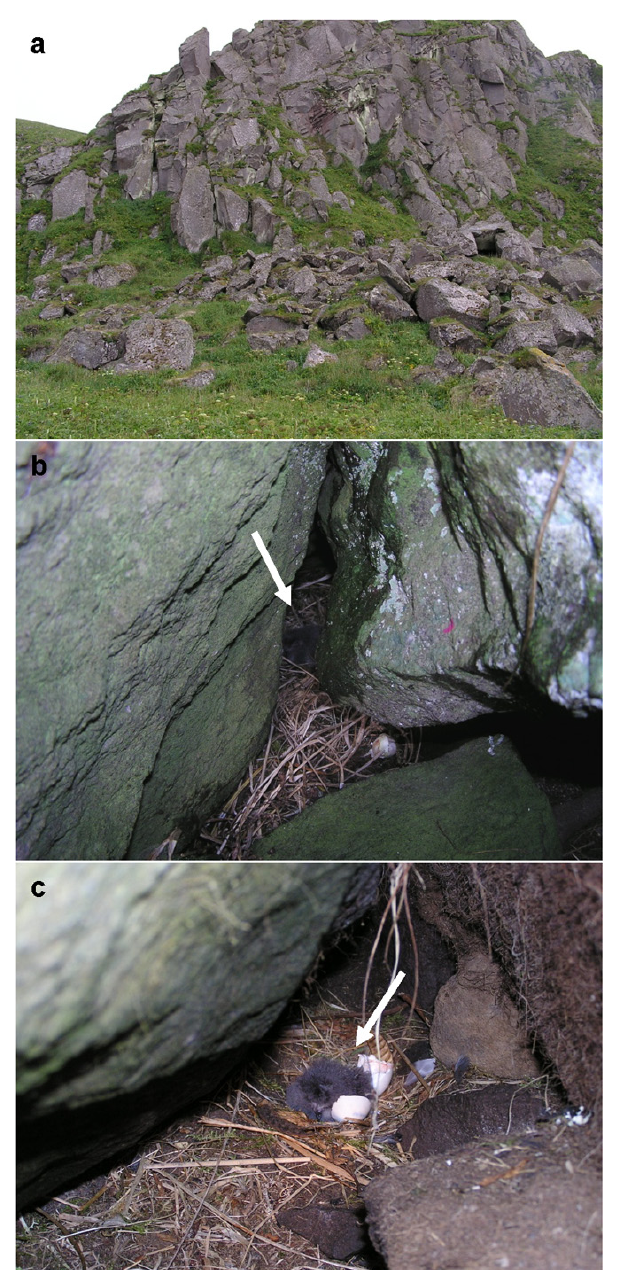
Fig. 1 . (a) Rock nesting habitat used by Fork-tailed Storm-Petrels ( Oceanodroma furcata ) on Kasatochi Island, Alaska. Nest sites vary from (b) nests made entirely of rock (here, nest material covers solid rock substrate), to (c) nests made up of a mix of rock and soil (here, soil composes substrate, right side, and part of roof; quantified as 40% rock). Arrows indicate location of